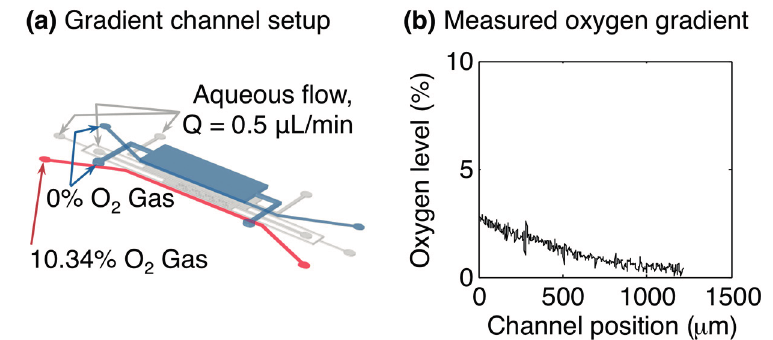
Figure 6. Oxygen gradient formation within the microfluidic oxygen control device. ( a ) Microfluidic channel setup for gradient measurement. L1GL was supplied with